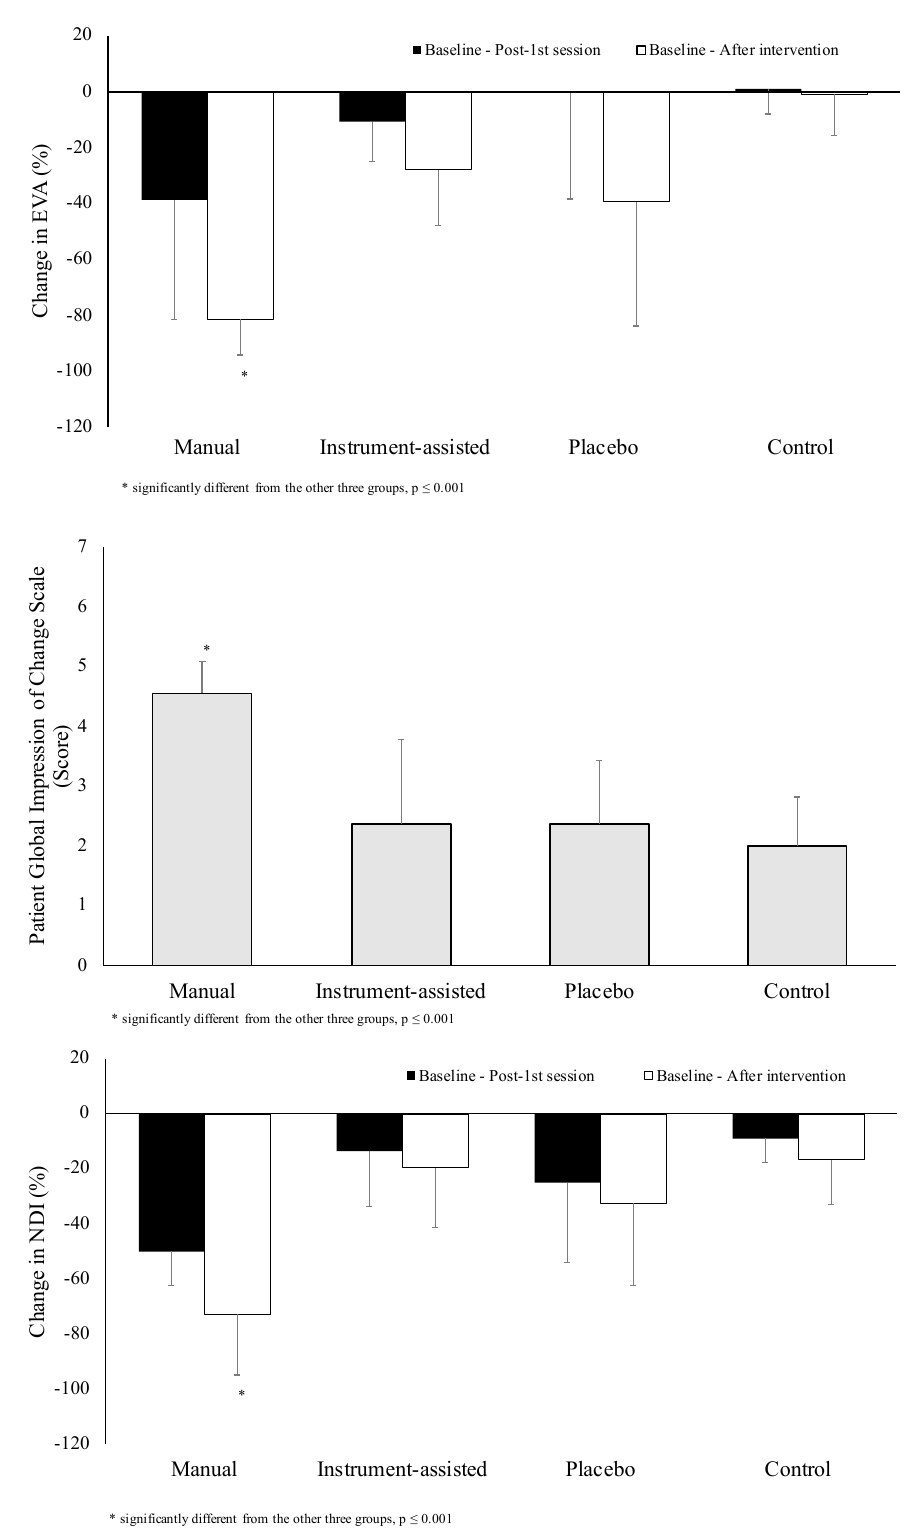
Figure 2. Immediate (baseline—post 1st session) and mid-term (baseline—after intervention) effects of the interventions in visual analogue scale (EVA), Neck Disability Index (NDI), and Patient Global Impression of Change Scale.